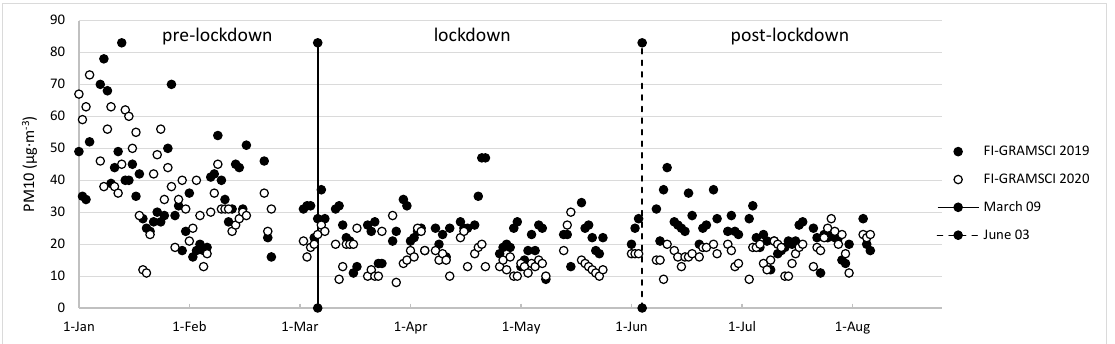
Figure 3. The daily mean concentration of PM2.5 ( μ g ∙ m − 3 ). In each graph, the lockdown period is depicted between the two vertical bars.